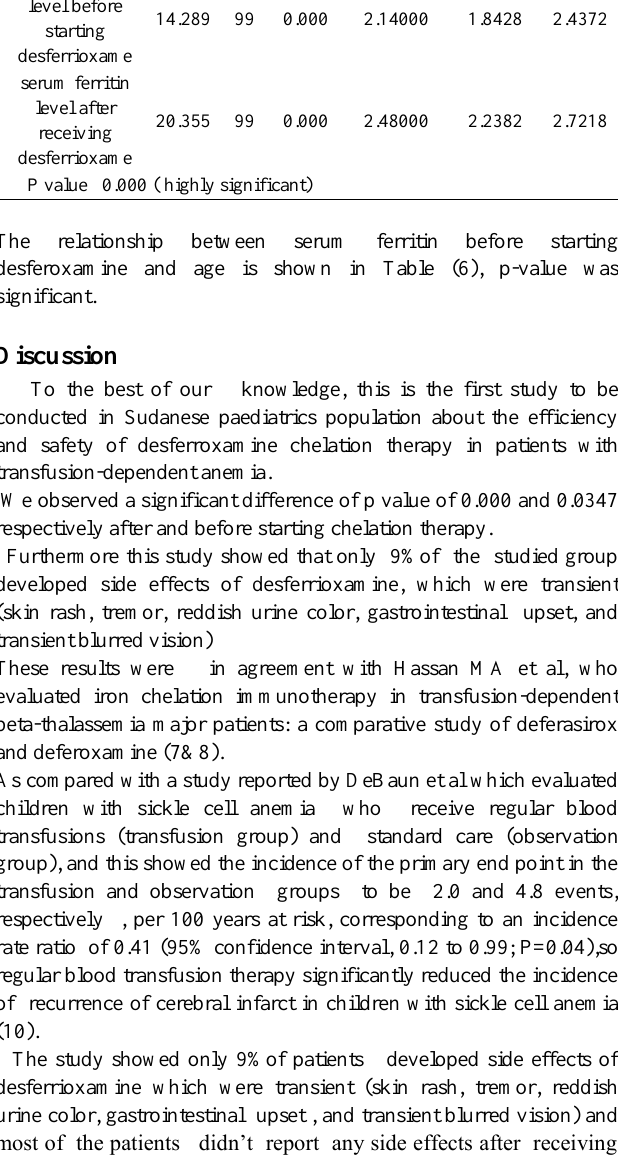
Table 5: The mean difference of serum ferritin before and after starting desferrioxamine therapy Test Value = 0 Confidence 95% Interval of the Sig. 2 Mean t df Difference tailed differences Lower Upper serum ferritin level before 14.289 99 0.000 starting desferrioxame serum ferritin level